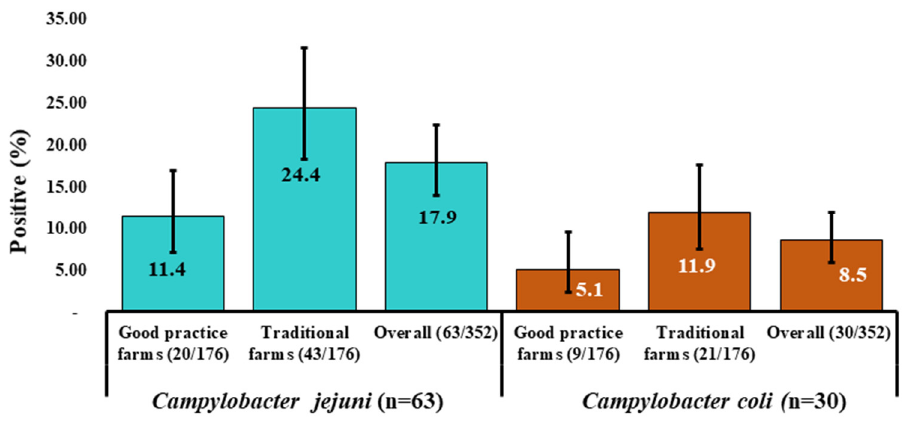
Figure 2. Distribution of occurrence of Campylobacter isolates (95% Confidence interval) that included C. jejuni ( n = 63) and C. coli ( n = 30) in two groups farms (good practice and traditional farms) in three districts of Bangladesh. The overall occurrence of Campylobacter spp. among the groups were significantly different ( p = 0.000).